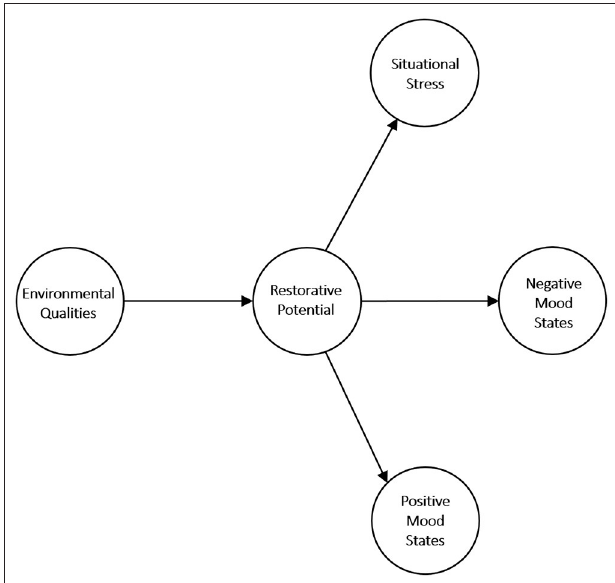
FIGURE 1 | The model of the restorative influence of environmental qualities of the place on mood and